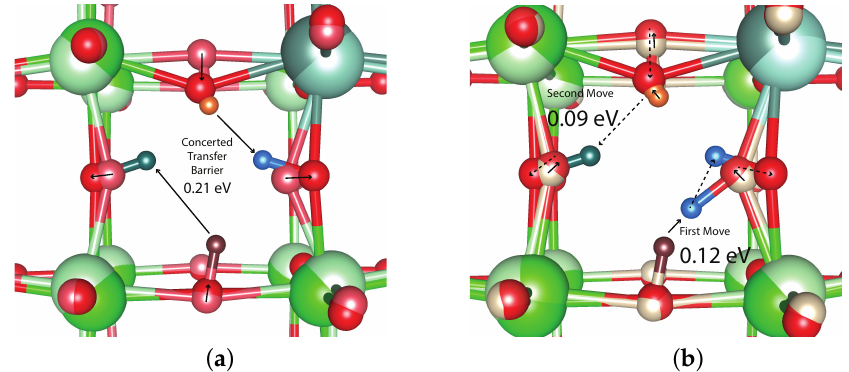
Figure 2. Two transfers from the original lowest-energy structure can happen in concert through a 0.21 eV barrier as seen in ( a ) or sequentially through 0.12 and 0.09 eV barriers as seen in ( b ). In ( b ), the motions in the first step are highlighted with solid arrows while the motions in the second step are highlighted with dashed arrows. While the barrier is shown by the arrow with the most significant movement in ( b ), many ion moves are part of each transfer. For each non-proton ion, the lighter colors are the earlier positions and the darkest the final